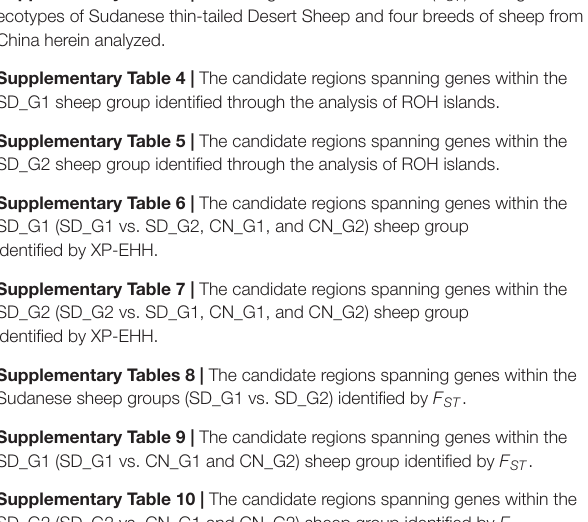
China herein analyzed.